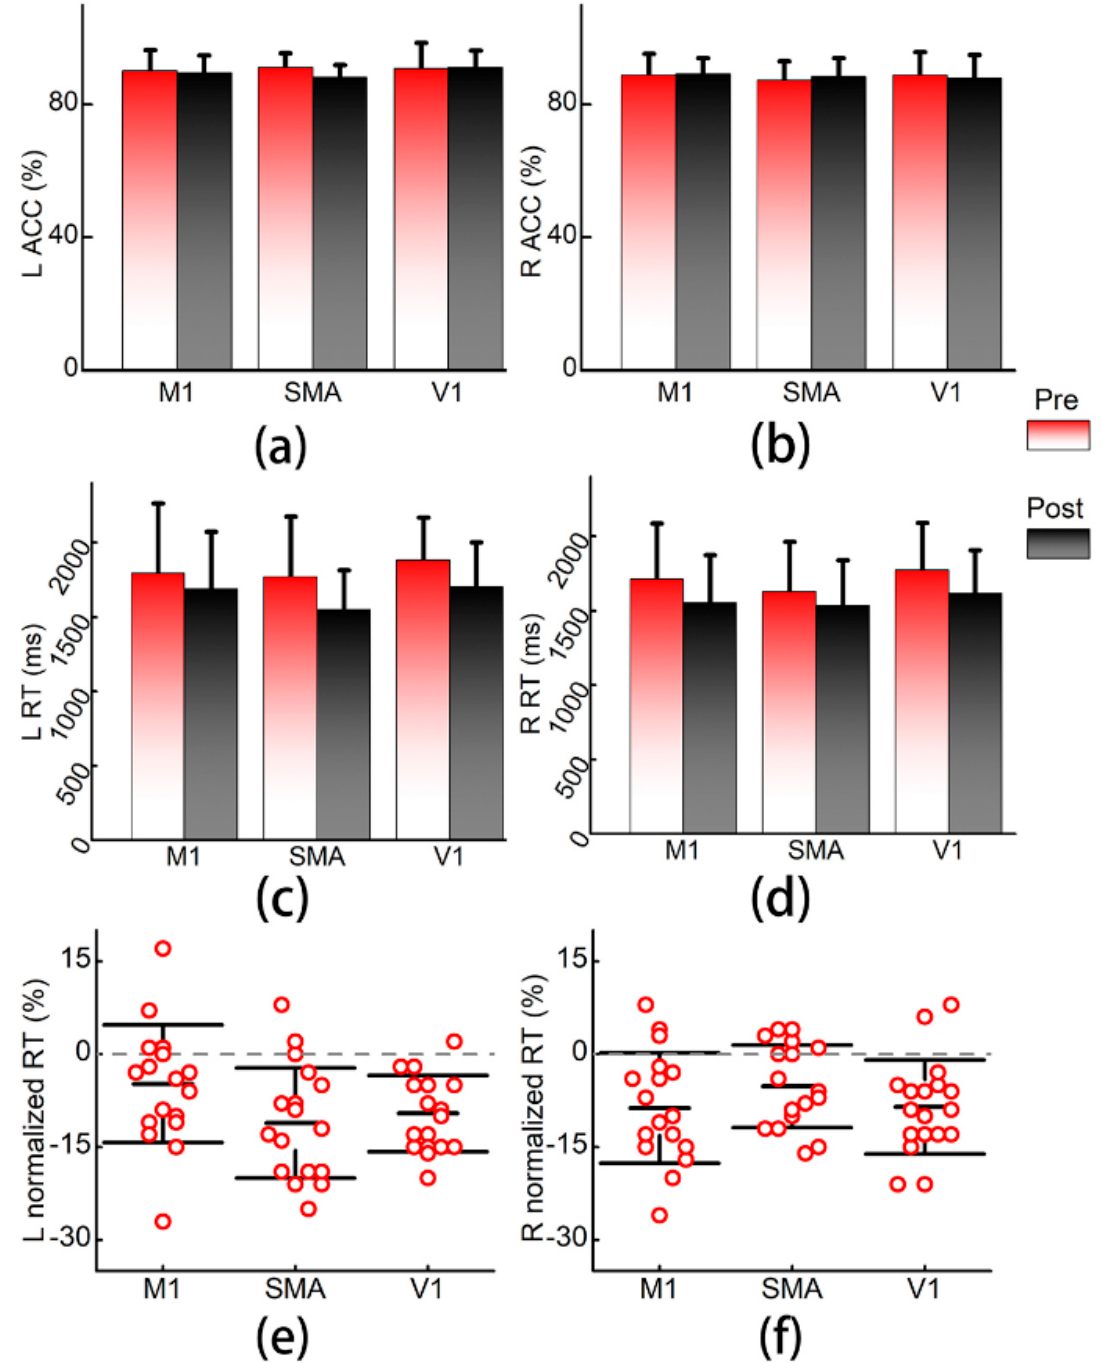
Figure 3. Results of the finger tapping task. ( a , b ) Accuracy rates of the left and right hands; ( c , d ) reaction time of left and right hands in milliseconds. ( e , f ) Comparisons of normalized reaction time. Error bars are standard diversions. L: left; R: right; ACC: accuracy rate; RT: reaction time; M1: primary motor cortex; SMA: supplementary motor area; V1: primary visual cortex.